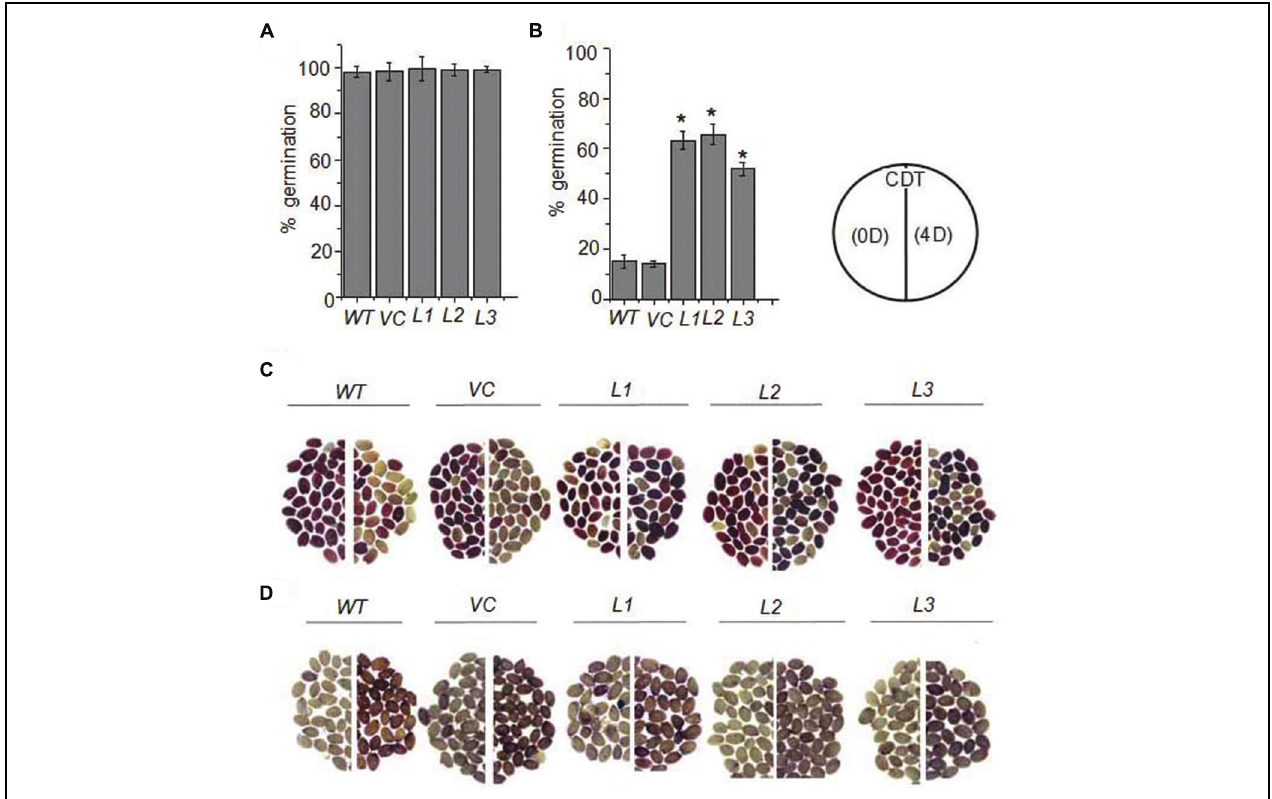
FIGURE 4 | Germination and viability of OsHSP18.2 overexpressing seeds after CDT. Six week-old seeds were subjected to 4 days of CDT as described in Materials and Methods. Germination analysis of WT, empty vector VC, and three OsHSP18.2 transgenic lines (L1, L2, and L3) before (A) and after (B) 4 days of CDT. (C) Tetrazolium assay for seed viability and (D) DAB staining for H 2 O 2 production of WT, empty vector (VC), and three OsHSP18.2 transgenic lines (L1, L2, and L3) before (left) and after 4 days of CDT (right). Age matched seeds were used for all germination experiments. In graph the values are mean ± SE of three independent sets ( n = 50). Asterisk indicate significant difference between WT and test genotypes ( ∗ P <